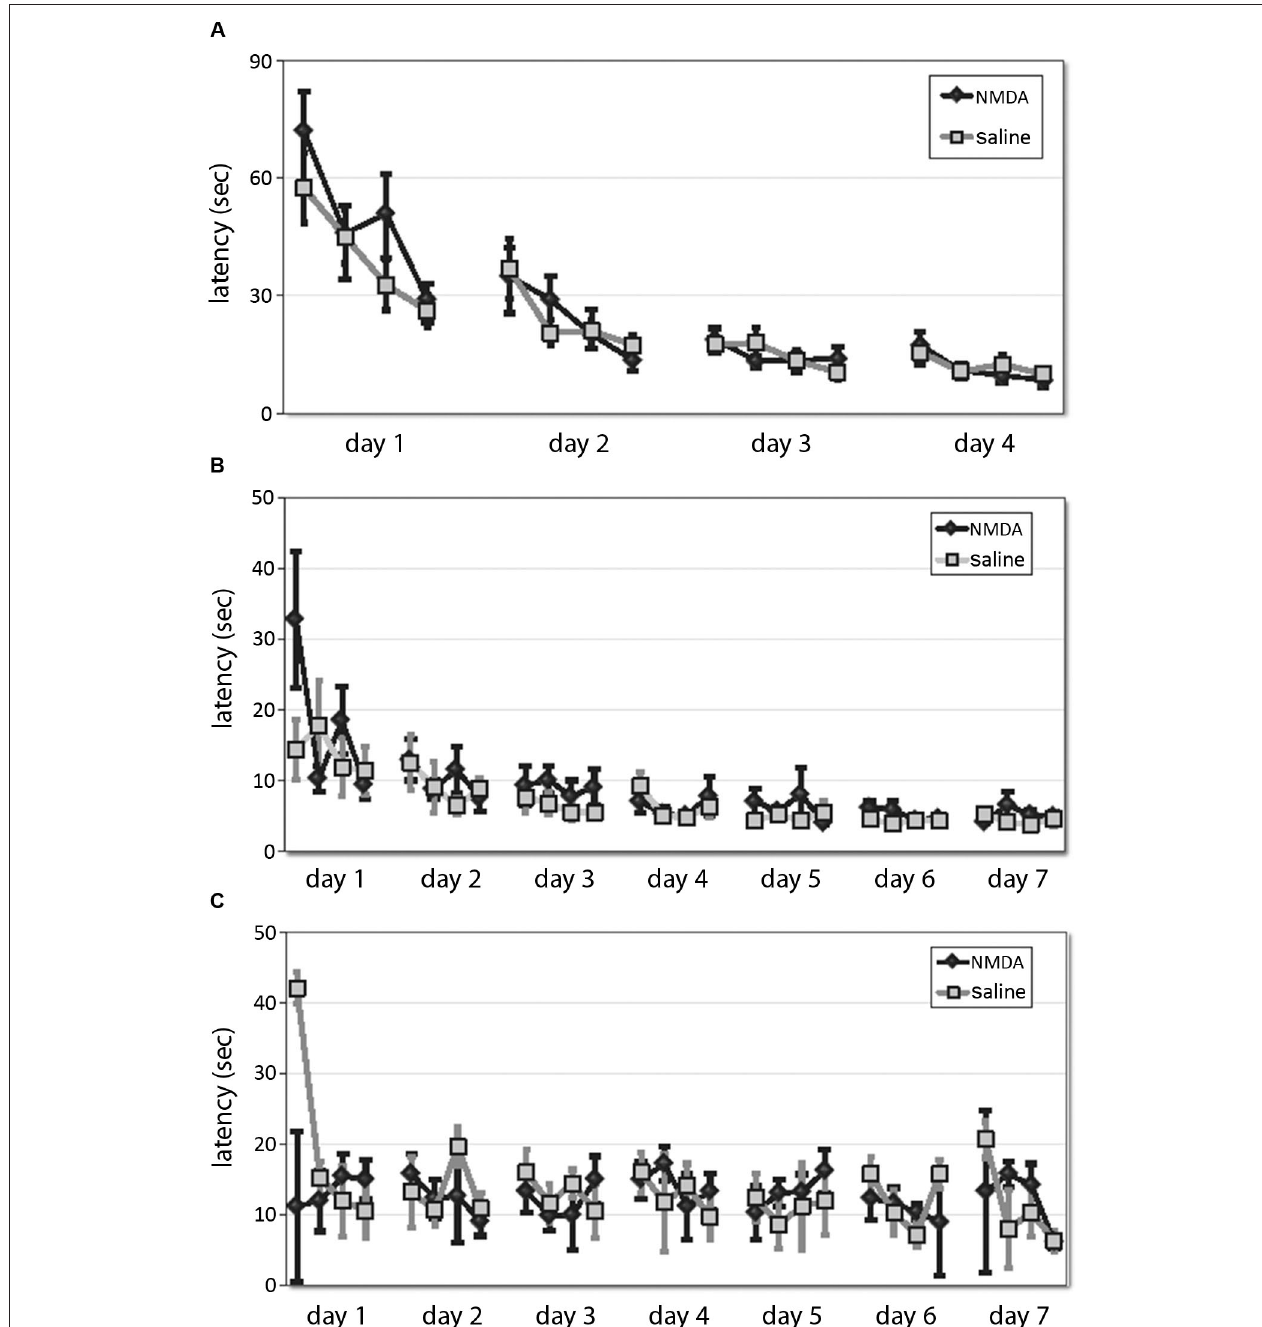
7 days of training in the 2-cue spatial or cued task, latencies decreased across training and were lower in the spatial task, but there was no effect of lesion either overall. (C) Similarly, in the cued task there was no effect of lesion on latency.